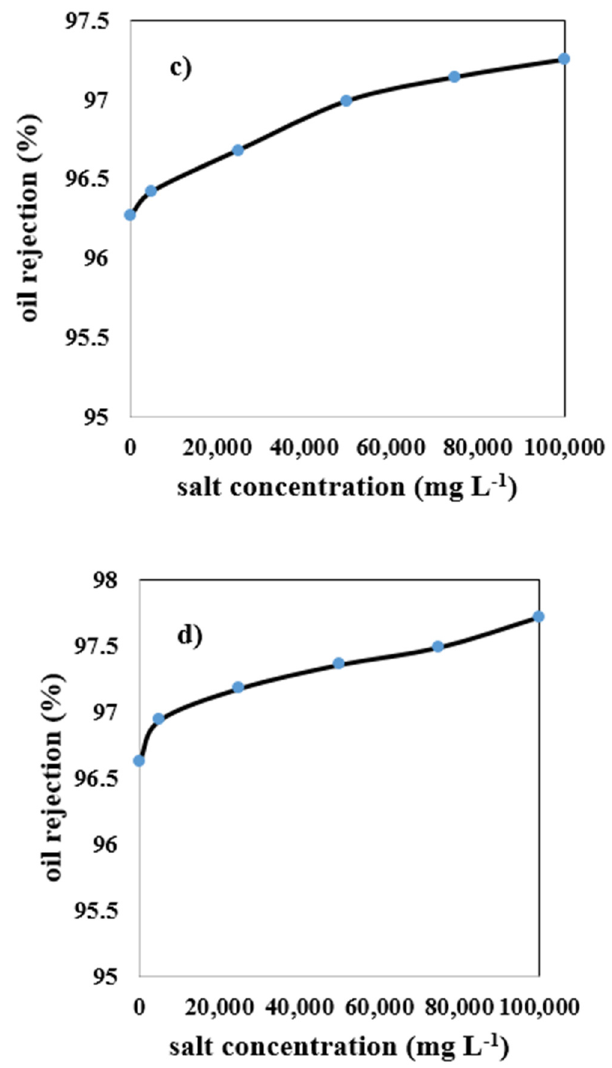
Figure 9. Effect of salt concentration on oil rejection of ceramic membranes ( a ) mullite, ( b ) mullite- alumina, ( c ) mullite-alumina-zeolite, ( d ) mullite-zeolite.